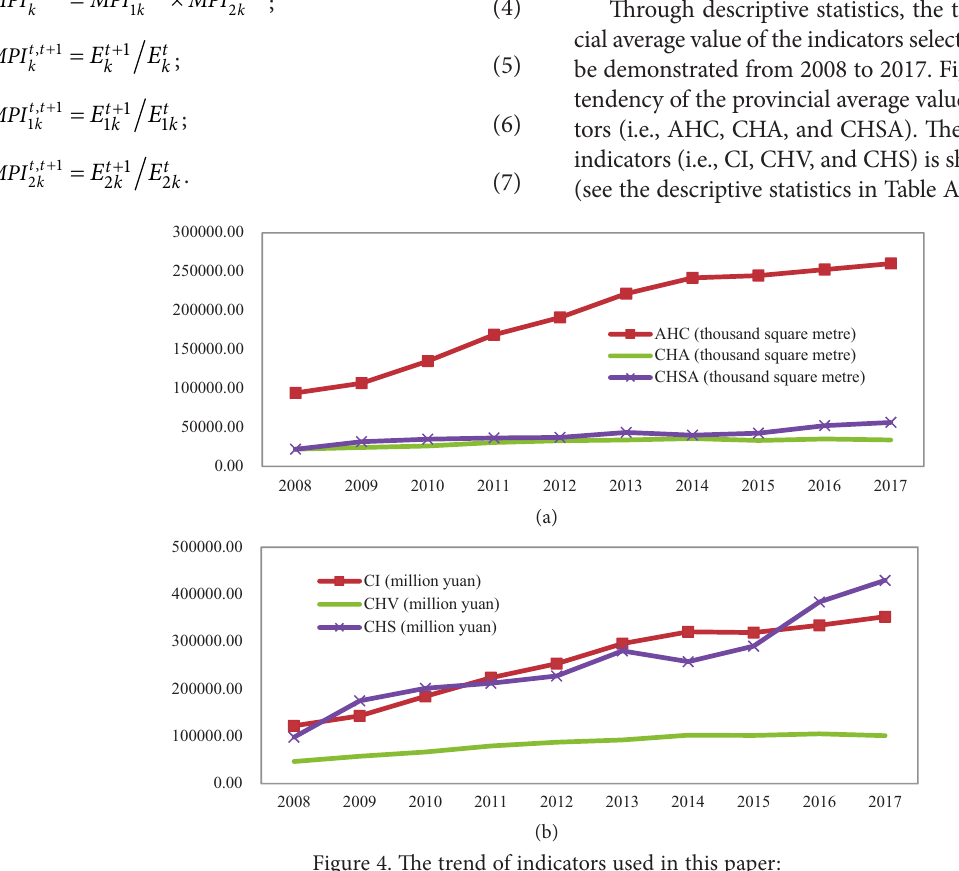
Figure 4. The trend of indicators used in this paper: a) Average area indicators; b) Average monetary